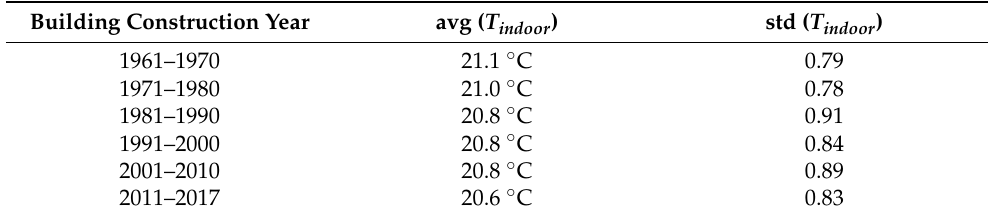
Table 3. Average indoor temperature and standard deviation of October–March in simulations utilizing RL.